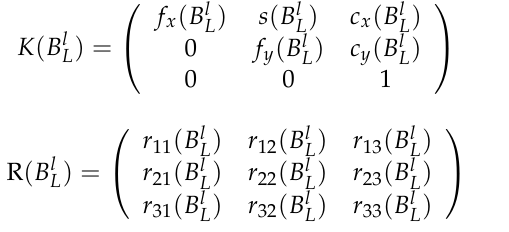
Figure 5. Concealment process based on derived homography matrix: ( a ) A part of the left ERP; ( b ) A part of the right ERP.